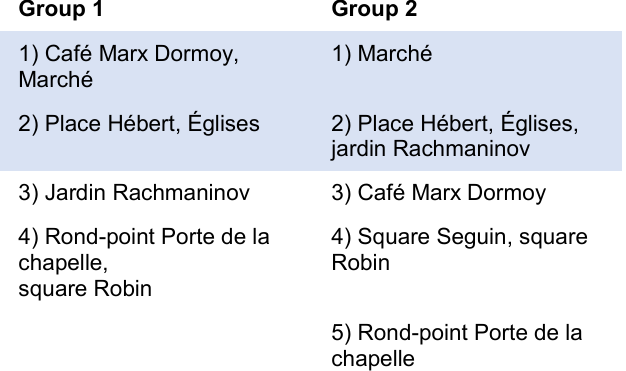
Figure 9. When we Count landmarks in sketch map for group 1 & 2, the importance of the landmarks varies from level 3, while the market place, the two churches and the place Hébert are common to the first 2 levels. (Frequent mentions of “buildings” and “parks” could not be counted because of the multiplicity of their locations.)